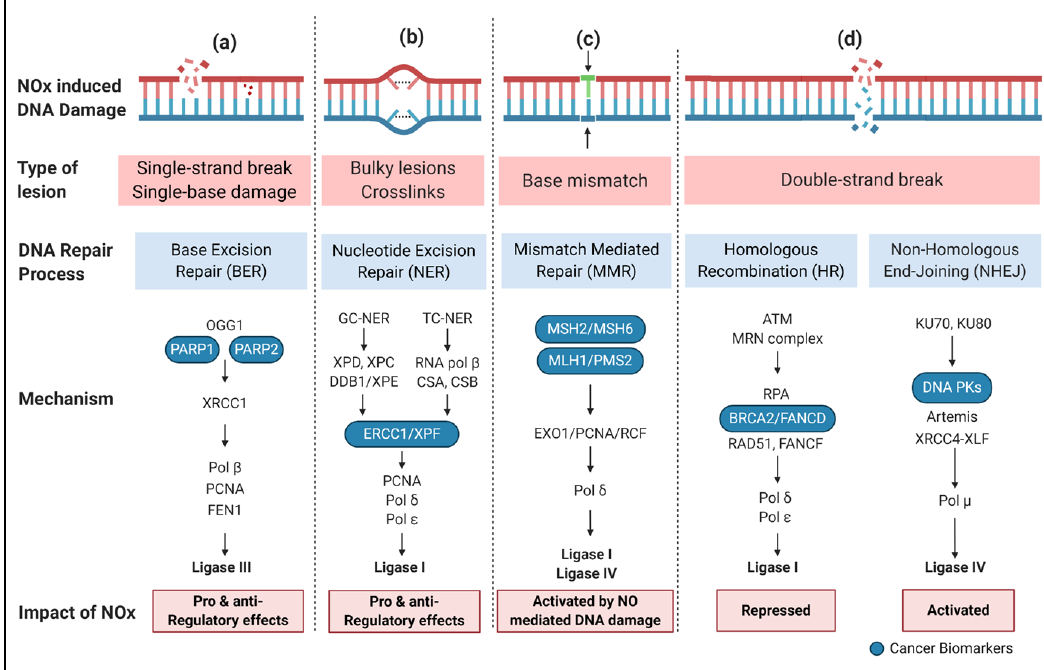
Figure 2. Effect RNS- induced DNA damage on DNA DAMAGE Repair (DDR) pathways: ( a ) RNS can have both pro- and anti-regulatory effects on base excision repair (BER) mechanisms in response to single strand DNA breaks; ( b ) RNS can have both pro- and anti-regulatory effects on nucleotide excision repair (NER) mechanisms in response to bulky DNA adducts; ( c ) mismatch mediated repair (MMR) mechanisms are activated in response to NO related DNA damage; and ( d ) non-homologous end joining repair (NHEJ) is favoured over homologous recombination (HR) in response to NO induced double stranded DNA breaks. Created with BioRender.com.